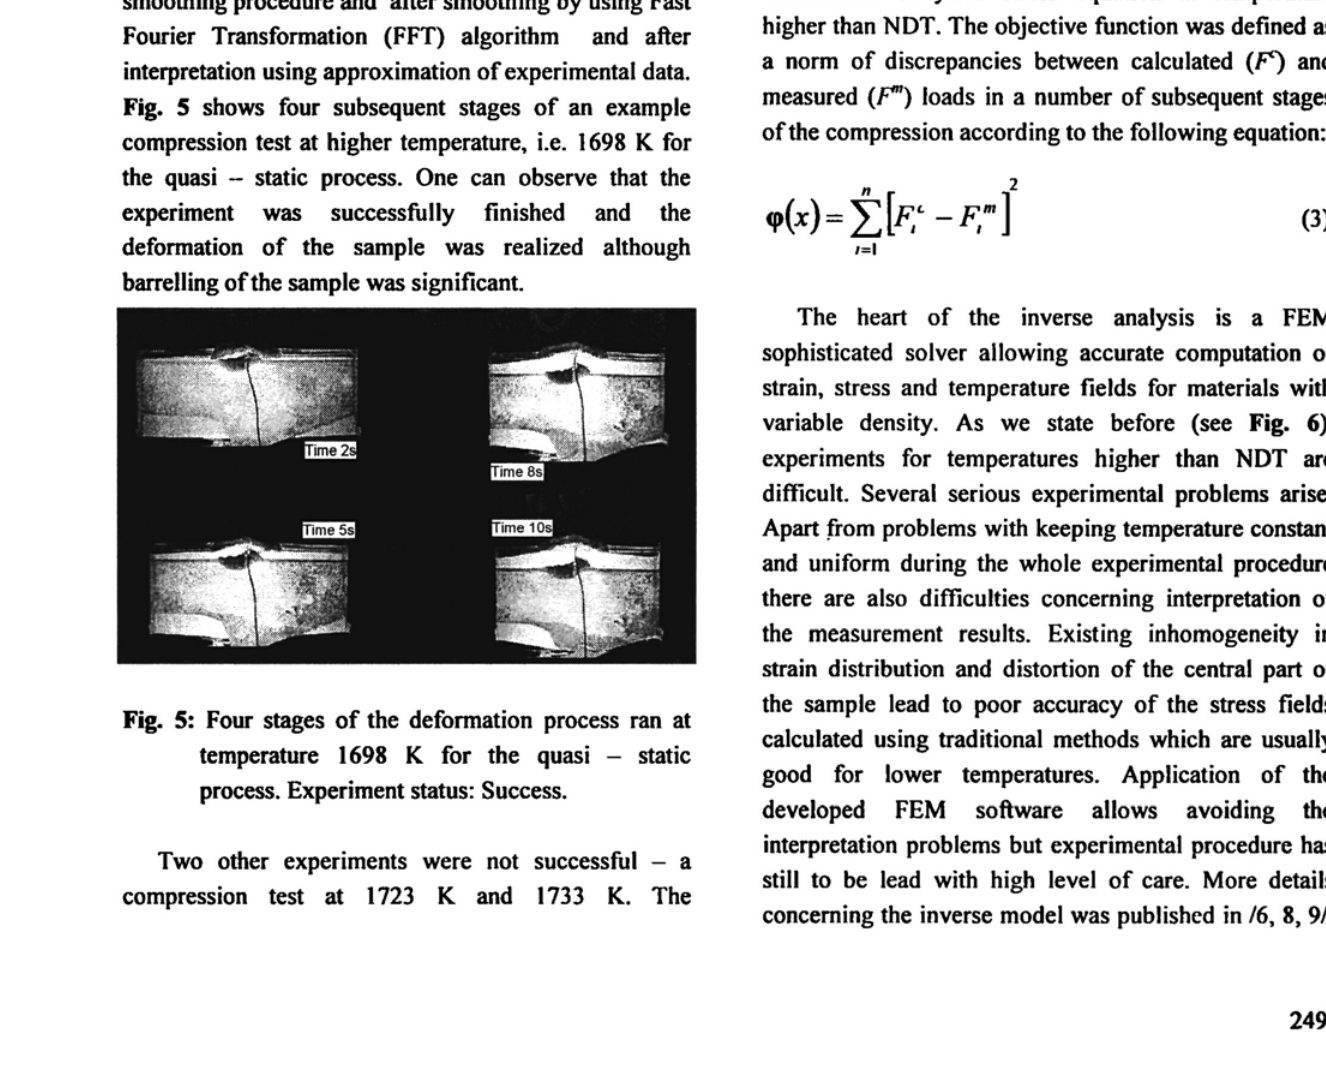
Fig. 6: Final shapes of the samples after deformation at 1698 K, 1723 K and 1733 K for the quasi - static